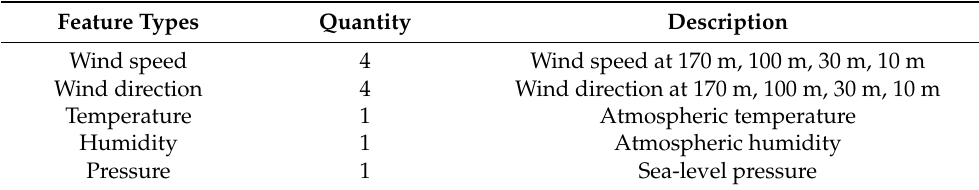
Table 1. Original numerical weather prediction (NWP) features of wind farms.